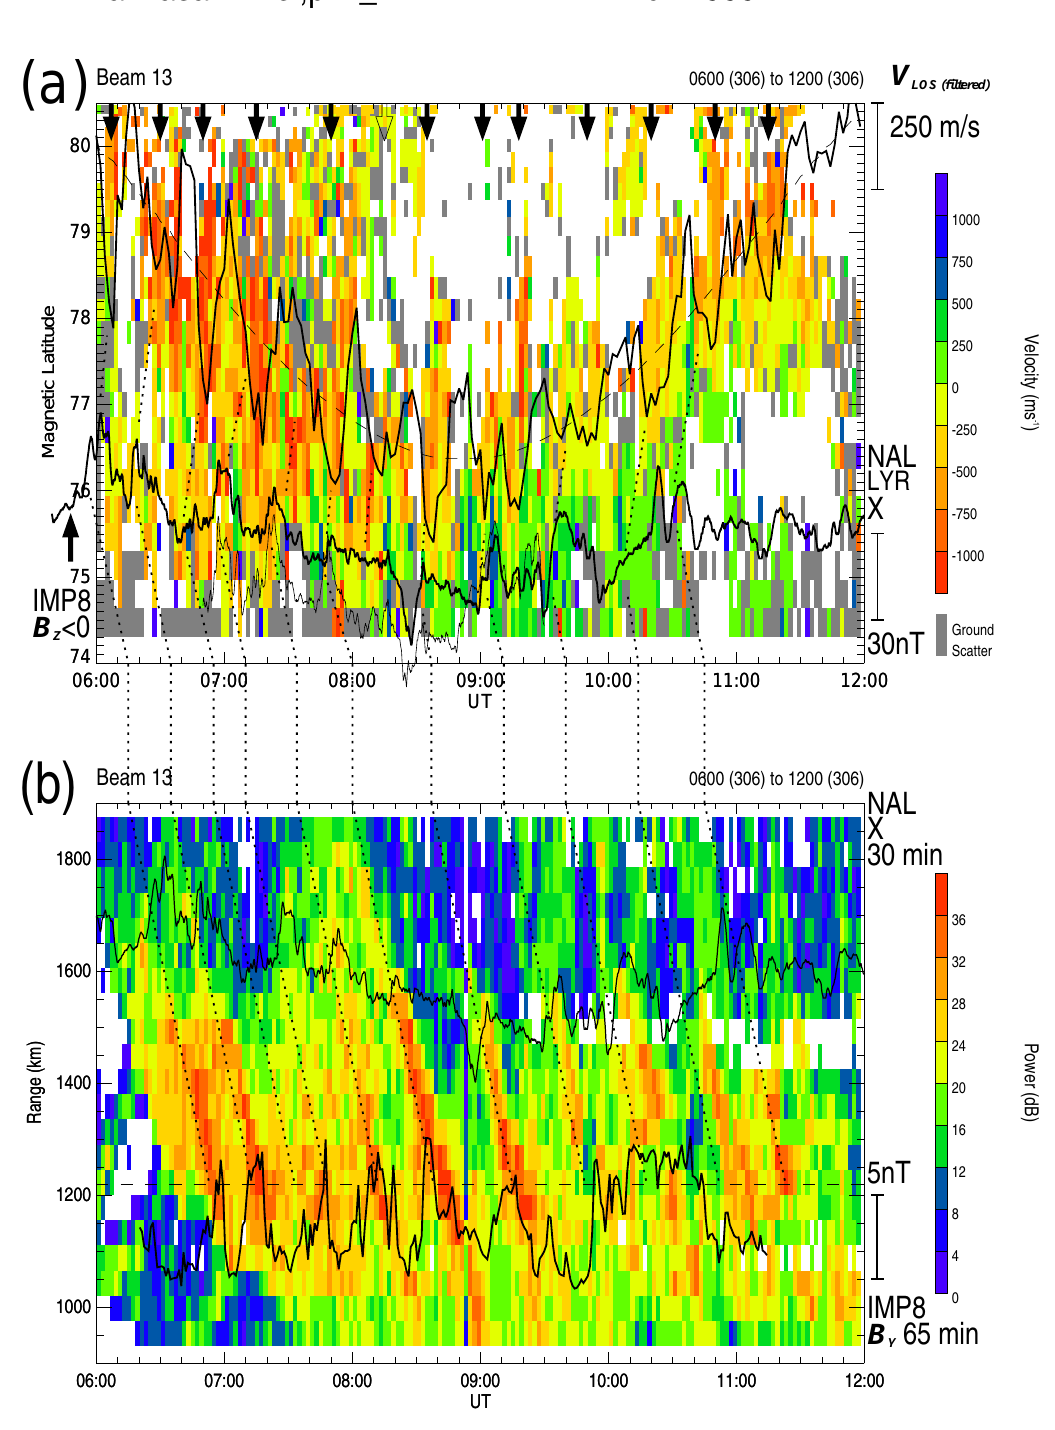
Fig. 6. ( a ) Radar LOS velocity at far ranges mapped in magnetic latitude and time. The downward-pointing arrows mark the PIF times determined from the pure-state filtered LOS velocity time series, one of which is plotted (top black solid line) about a zero baseline (dashed line). Also, the ground magnetic field X components measured at Ny ˚Aleslund (NAL) and Longyearbyen (LYR; thin line) are superposed. The arrival time of the IMF B z < 0 is shown on the left. The dotted lines are drawn to suggest a correspondence between the NAL X component positive (northward) deflections and PIFs. ( b ) The radar ground-scatter power at near ranges. Superposed are time series of the IMP-8 IMF B y (shifted by 65min) and the NAL ground magnetic field X component (shifted by 30min). The dotted lines along the TID bands are superposed to show the correspondence between the ground magnetic field perturbations and the IMF − B y